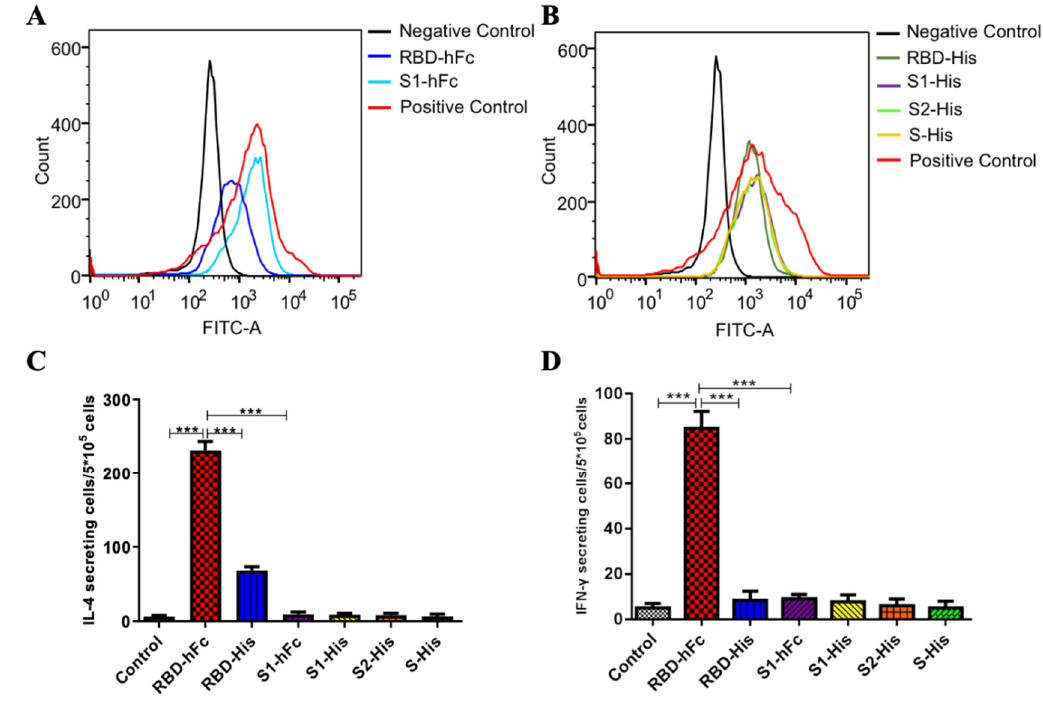
Figure 3. Mice antisera inhibited RBD binding to ACE2 and splenocytes of RBD-hFc immunized mice significantly increased cytokines secretion. ( A ) Inhibitions of RBD-His binding to cell-expressed ACE2 by RBD-hFc and S1-hFc mice antisera were measured by flow cytometry. ( B ) Inhibitions of RBD-hFc binding to cell-expressed ACE2 by RBD-His, S1-His, S2-His and S-His mice antisera were measured by flow cytometry. ( C ) Number of IL-4 secreting cells in splenocytes stimulated by recombinant subunit protein vaccines on day 40. ( D ) Number of IFN-γ secreting cells splenocytes stimulated by recombinant subunit protein vaccines on day 40. Data are presented as mean ± SD; *** p < 0.001.